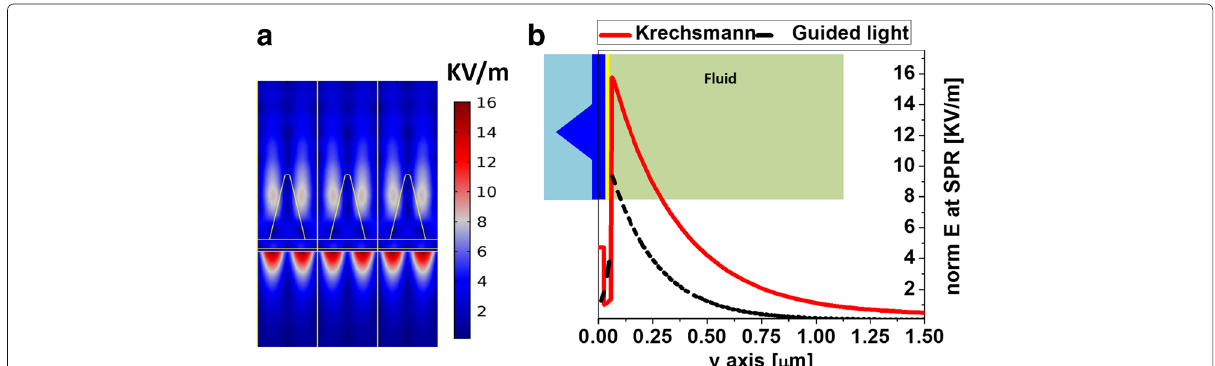
Fig. 2 a Map of the modulus of the electric field at λ = 758 nm for an input electric field amplitude of 1 V/m and polarized as a TM mode (electric field parallel to the map). b Profile of the electric field magnitude along the direction of propagation for the Krestchmann configuration ( black dashedline ) and for the nanoprism device ( redsolidline